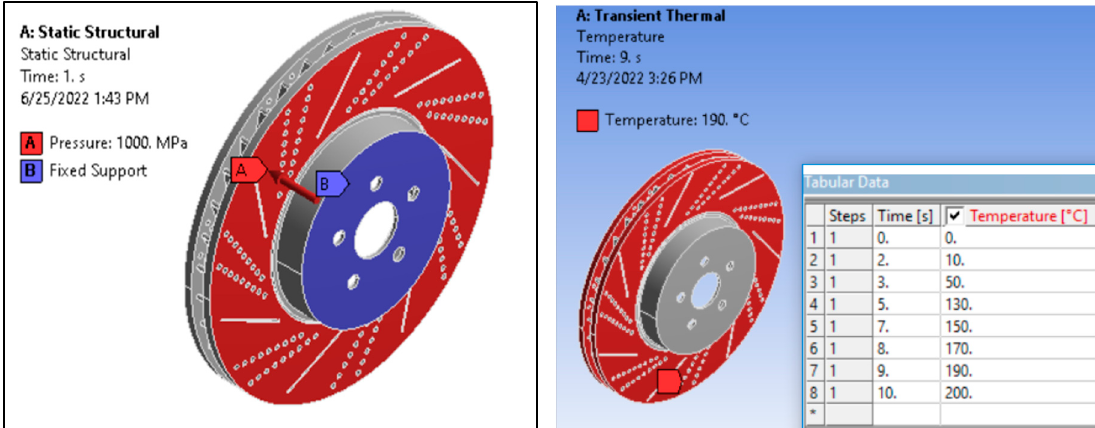
Figure 3. Boundary conditions for mechanical and thermal analysis.